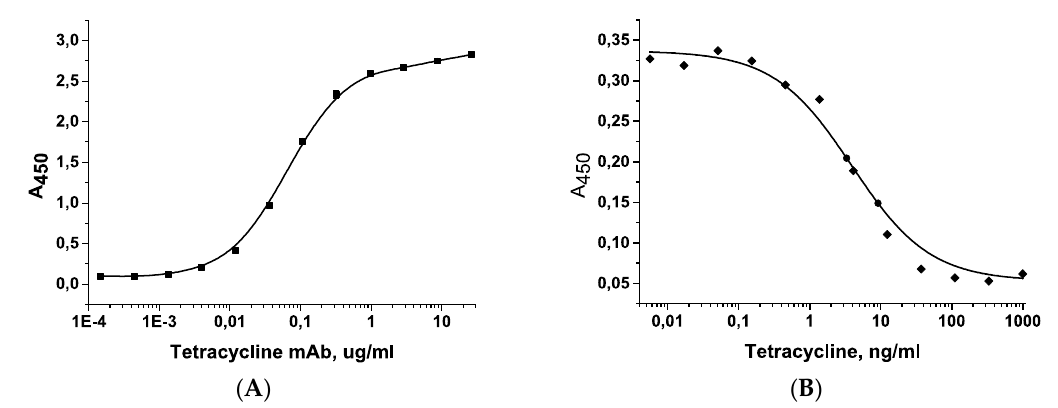
Figure 1. ( A ) Titration of the antibody to tetracycline on immobilized tetracycline-bovine serum albumin conjugate (TET-BSA) conjugate (y = 0.08738 + (2.76344 − 0.08738)/(1 + (x/0.06759) 1.11347 ), R 2 = 0.99956); ( B ) calibration curve of competitive determination of tetracycline by ELISA (y = 0.053 + (0.337 − 0.053)/(1 + (x/3.92817) 0.79295 ), R 2 = 0.99956).